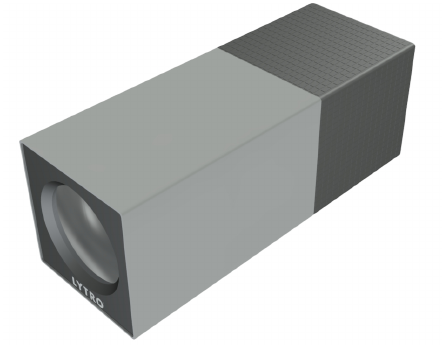
Figure 1. The Lytro LF (Light-Field) camera used in this